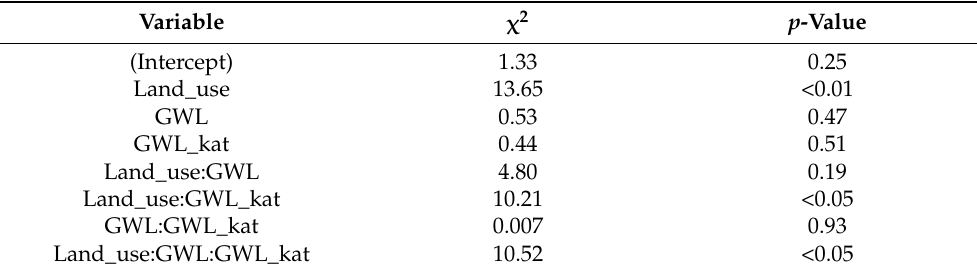
Table 6. The linear mixed-effect model CH 4 -C flux variable significance (model coefficients presented in Table